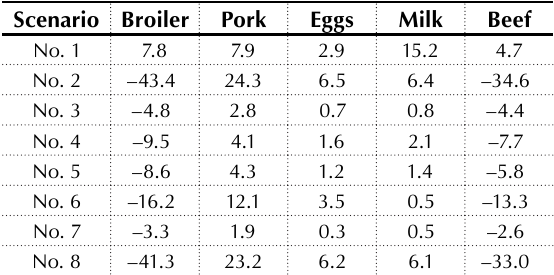
Table 3. Regression results for animal production